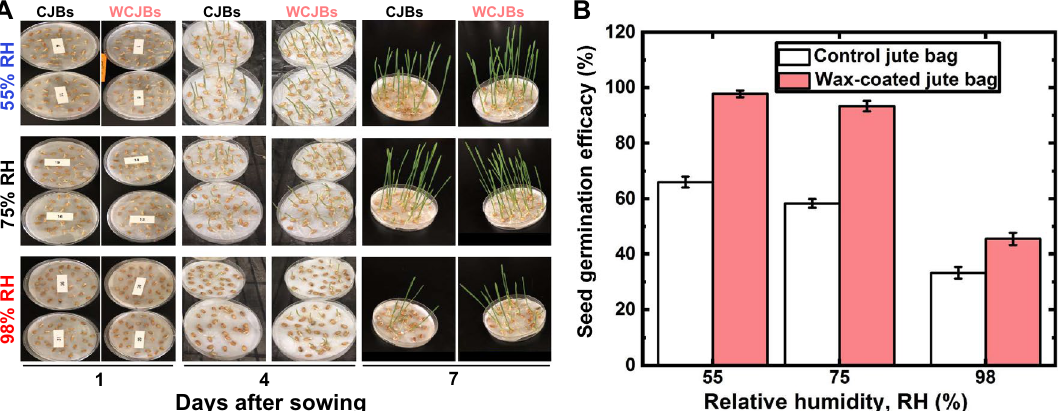
Figure 6. Seed germination on Petri dishes of wheat grains stored for 8 weeks in control jute bags (CJBs) and wax-coated jute bags (WCJBs) under different relative humidity (RH) conditions. ( A ) Seed germination patterns monitored for 7 days after sowing and ( B ) germination of seeds stored in control jute bags and WCJBs at 55%, 75%, and 98% RH. The percentage seed germination of wheat grains stored in WCJBs was higher than that of wheat grains stored in CJBs under all RHs. Error bars represent the standard error (± SE) of means from 90 seeds/treatment.